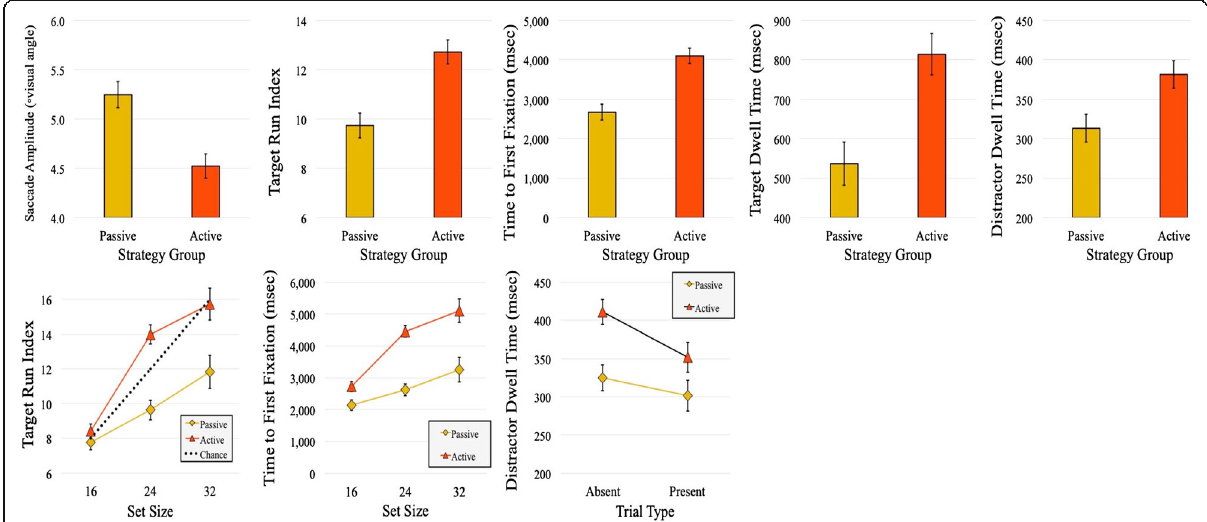
Fig. 5 Significant main effects and interactions with strategy, from experiment 2, eye-trackings measures. The top row presents all main effects, and the bottom row presents all two-way interactions. The dotted line in the plot of target run index indicates the number of items that would be expected to be fixated upon due to chance alone, if no attentional guidance was present. Error bars represent one standard error of the mean